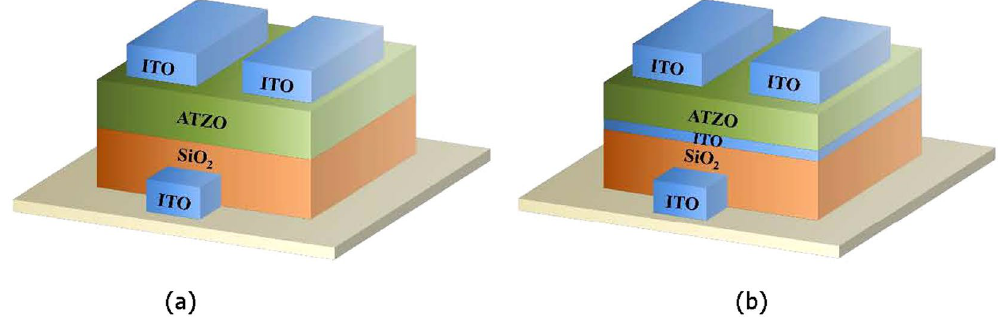
Figure 7. The schematic structures of ( a ) the single-channel ATZO and ( b ) the double-channel ITO/ATZO as the gate insulator layer, was formed by plasma enhanced chemical vapor deposition (PECVD). The deposi- tion temperature was 80 °C. To create better interface properties between the insulator and channel layer, the ATZO channel layer was deposited by RF magnetron sputtering successively after formation of the SiO 2 film at room temperature. The wt% of SnO 2 and Al 2 O 3 in the ATZO sputtering target are both 2%. The oxygen partial pressure [O 2 /(O 2 + Ar)] in the sputtering chamber was 15% and the channel layer was 40-nm-thick. Finally, an ITO source/drain electrode was deposited using the same process conditions with the gate electrode after formation of the channel layer. For the double-channel structure, we introduced the ITO film as the bottom channel layer between the insulator and ATZO channel layer to optimize the electrical performances. The oxygen partial pressure of the ITO film was 5%. The total channel thickness was 40 nm, including a 5-nm-thick ITO and 35-nm-thick top ATZO channel layer. Figure 7 shows the schematic structures of the single-channel ATZO and the double-channel ITO/ATZO TFTs. During the fabrication process, we adopted standard photolithography and lift-off technique. The electrical performances of the ATZO TFTs was measured using a semiconductor parameter analyzer (Agilent 4156 C) at room temperature. The chemical states of atoms in the ATZO films were investigated using X-ray photoelectron spectroscopy (XPS, Axis Ultra). The crystal quality conditions of ATZO films were tested using X-ray diffraction (XRD, Rigako).